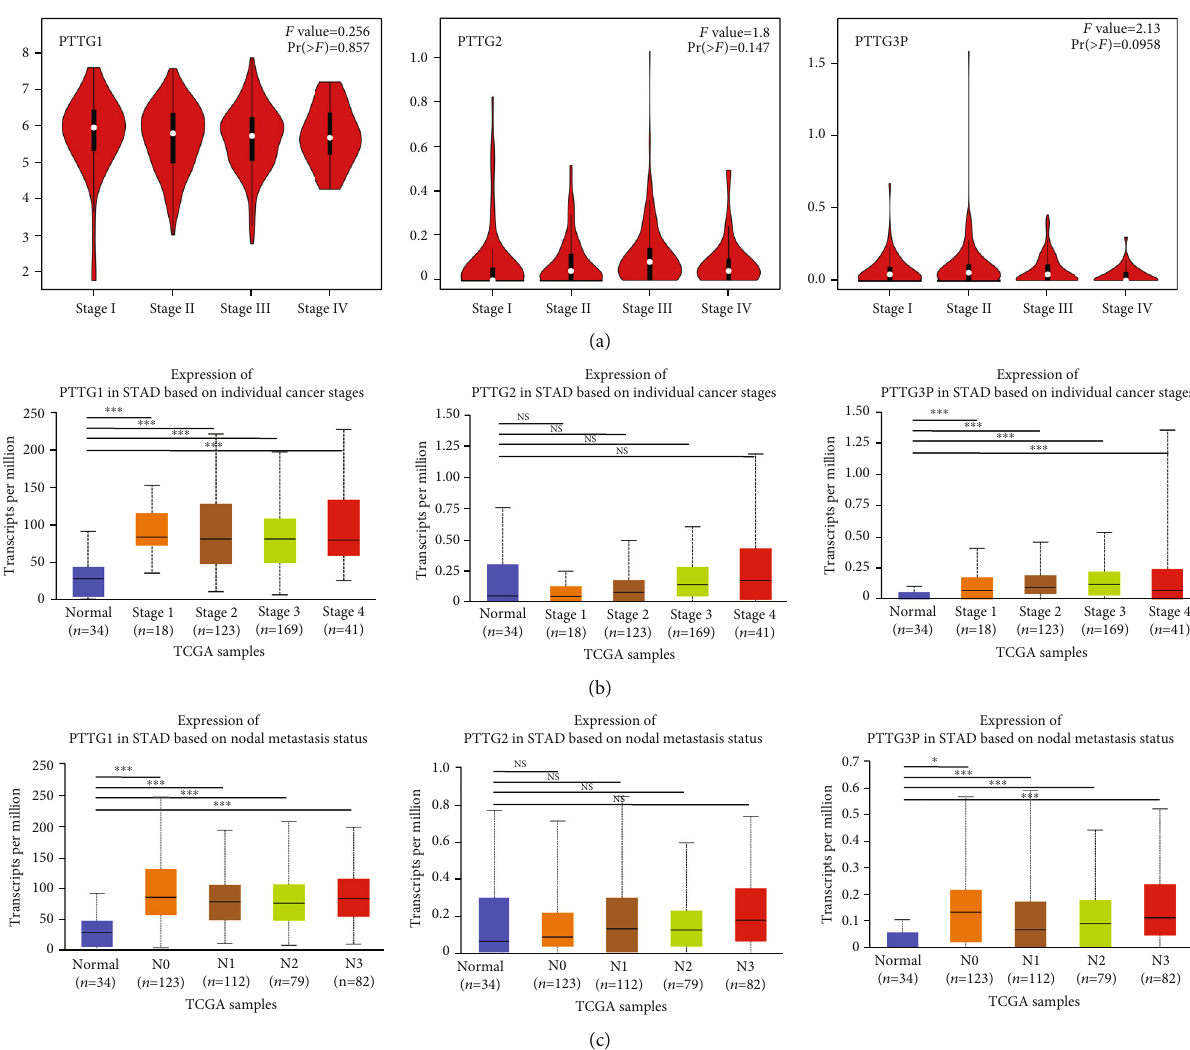
Figure 3: Clinicopathological characteristics associated with STAD and the expression of PTTGs. (a) The correlation of PTTG mRNA expression with tumor grade in individuals with STAD. The variations in PTTG mRNA expression throughout STAD tumor stages are shown using violin plots. One-way analysis of variance was used to test for statistical signi fi cance (ANOVA). It was determined that a p value of 0.01 was statistically signi fi cant. (b) Staging of STAD according to PTTG mRNA expression and clinicopathological stages (UALCAN). (c) Nodal metastases and PTTG mRNA expression in patients with STAD (UALCAN). ∗ p < 0 : 05 and ∗∗∗ p < 0 : 001 ; NS: no